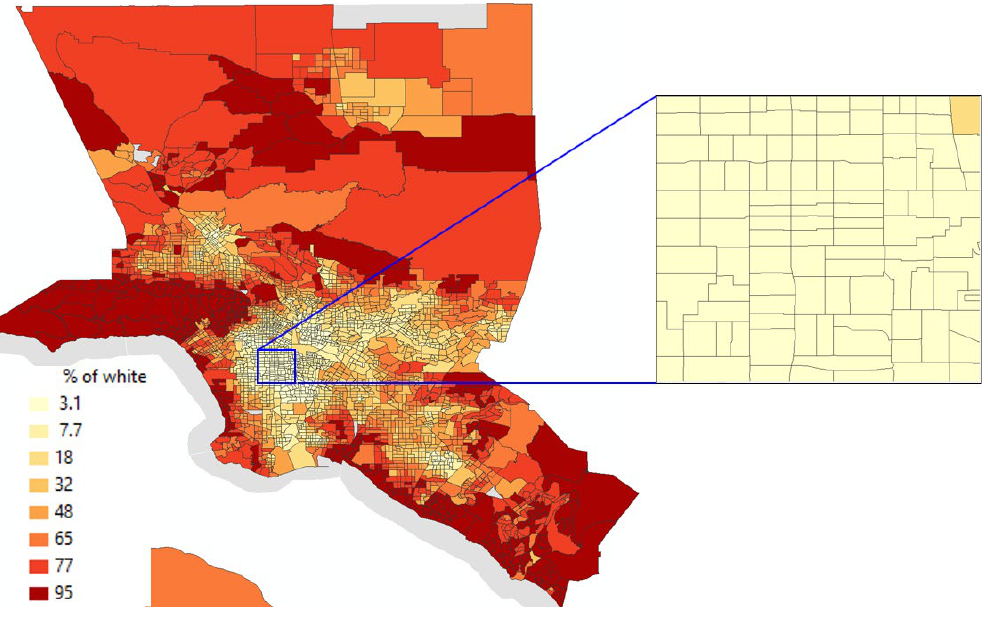
Figure 2. Limitation of Choropleth maps created by ArcMap and ArcGIS Pro.